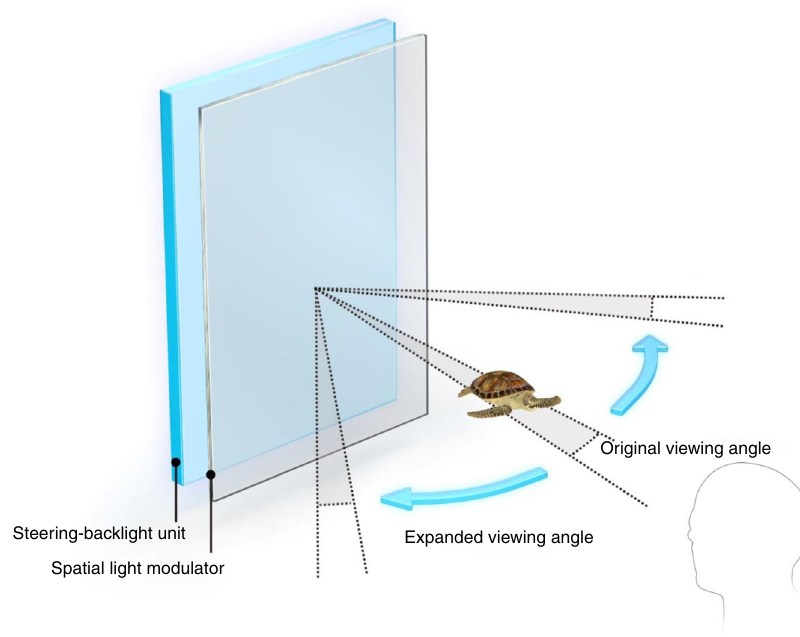
Fig. 2 The schematic diagram of expanding effective SBP by using steering-backlight unit. In addition to the original viewing angle of holograms provided by the spatial light modulator, the steering-backlight unit effectively enhances the overall viewing angle.